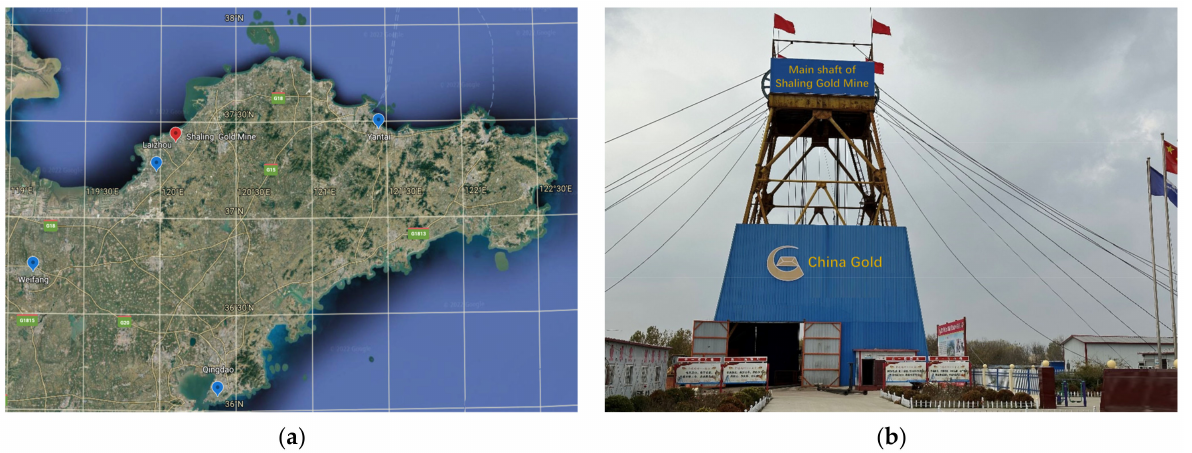
Figure 1. ( a ) Location map of the main shaft of the Shaling Gold Mine; ( b ) construction site of the main